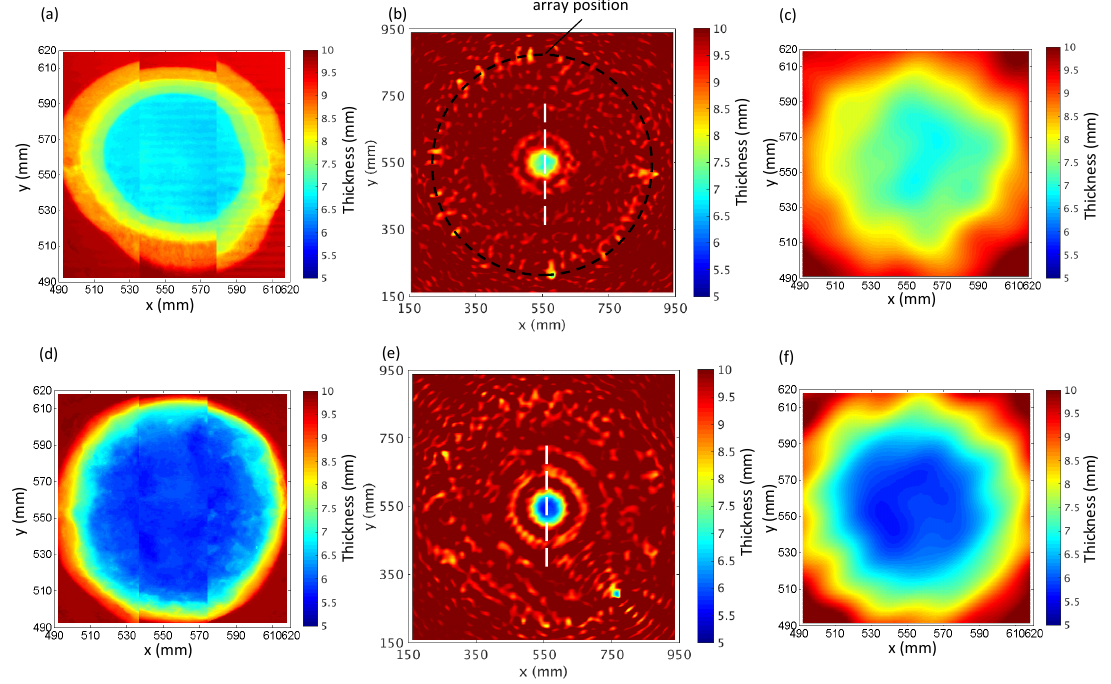
Figure 8. Thickness mapping of the corrosion defect A and B. ( a ) Laser measured profile of defect A after post-processing, ( b ) thickness reconstruction from FWI at 60 kHz and ( c ) a zoomed-in view of defect A from ( b ). The dashed curve presents the position of the array. ( d ) Laser measured profile of defect B after post-processing, ( e ) thickness reconstruction from FWI at 60 kHz and ( f ) a zoomed picture of defect B from ( e